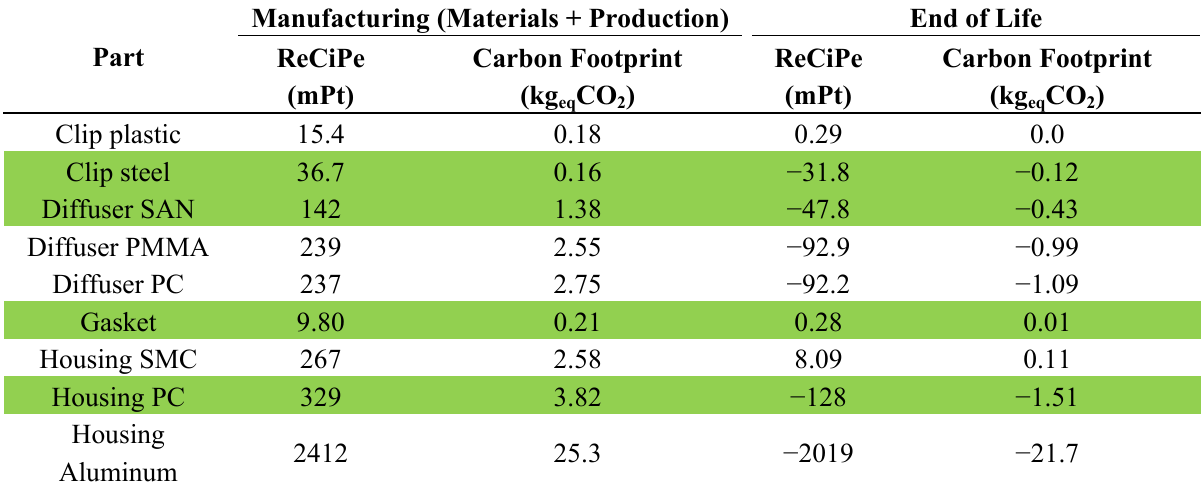
Table 9. Results for Scenario